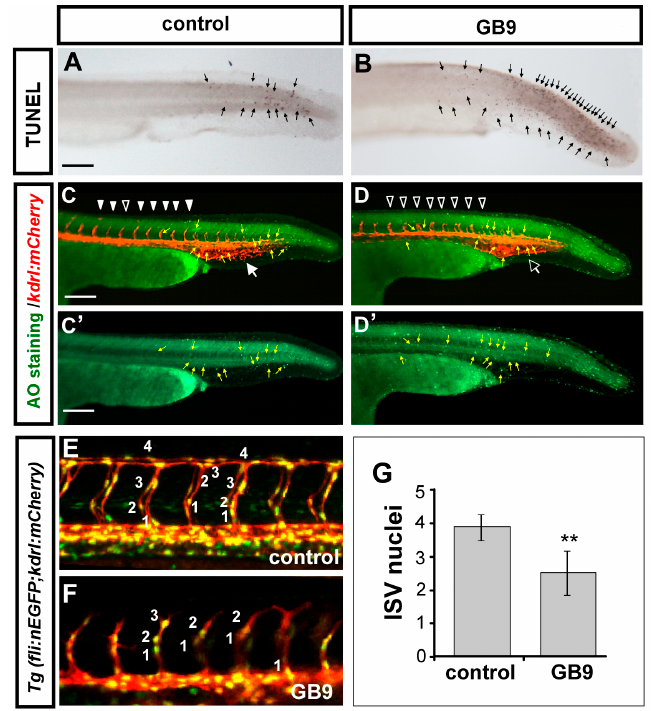
Figure 4. GB9 treatment inhibits the growth of ISV cells. ( A – D ) At 30 hpf, TUNEL labeling (in wild-type AB strain) and AO staining (in Tg ( kdrl:mCherry ) embryos) were used to detect apoptotic cells ( arrows in ( A , B ) and green spots in ( C , C’ , D , D’ )) in 0.3% DMSO control ( A , C , C’ ), and GB9-treated embryo ( B , D , D’ ). Some increased apoptotic cells were observed on the skin close to tail region in GB9 treated embryo, but not in vascular regions compared to untreated controls ( yellow arrows in ( C , C’ , D , D’ )). At 30 hpf, ISVs show slower growth at mid-somite in the GB9 treated Tg ( kdrl:mCherry ) embryos ( hollow arrowheads in ( D )) and less endothelial cell sprouting and loop formation at CVP ( hollow arrow in D ) compared to control embryos ( arrowheads and arrow in ( C ). The number of cells forming each ISV counted in control Tg ( kdrl:mCherry; fli1a:negfp y7 ) ( E ) and GB9-treated embryos ( F ) at 30 hpf. ( G ) Quantification of average endothelial cells per ISV is 3.9 ± 0.3 (ISV n = 60) and 2.2 ± 0.5 (ISV n = 80) in control and GB9 treatment respectively. ** refers to p < 0.001 by an unpaired Student’s t -test. Scale bars are 100 µ m for ( A – F ).